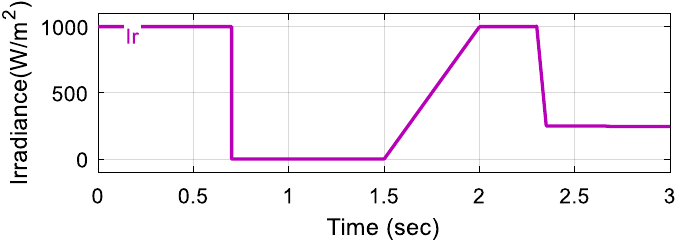
Figure 10. Irradiance variation for PV array.